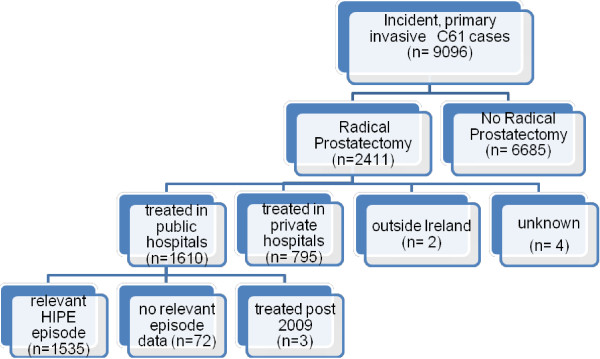
Radical prostatectomy in men aged < 70 years at diagnosis, 2002–2008, dataset overview.